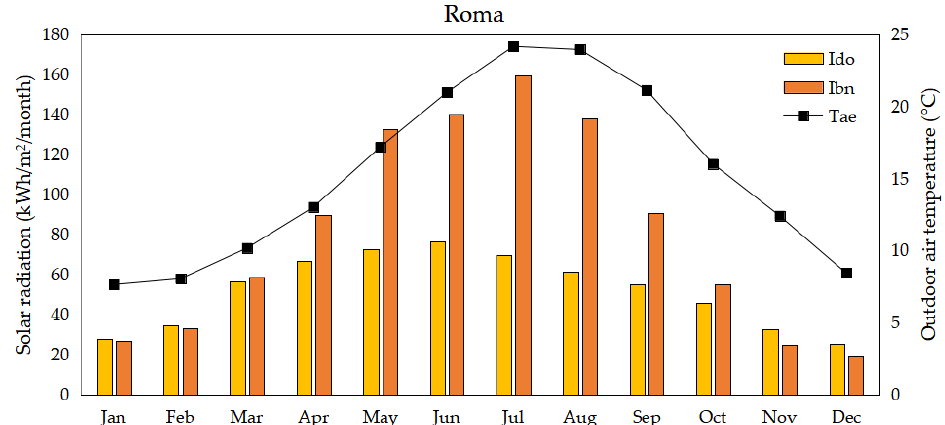
Figure 1. Monthly average climate data for Rome: diffuse irradiance on horizontal plane, direct normal irradiance and outdoor air temperature.